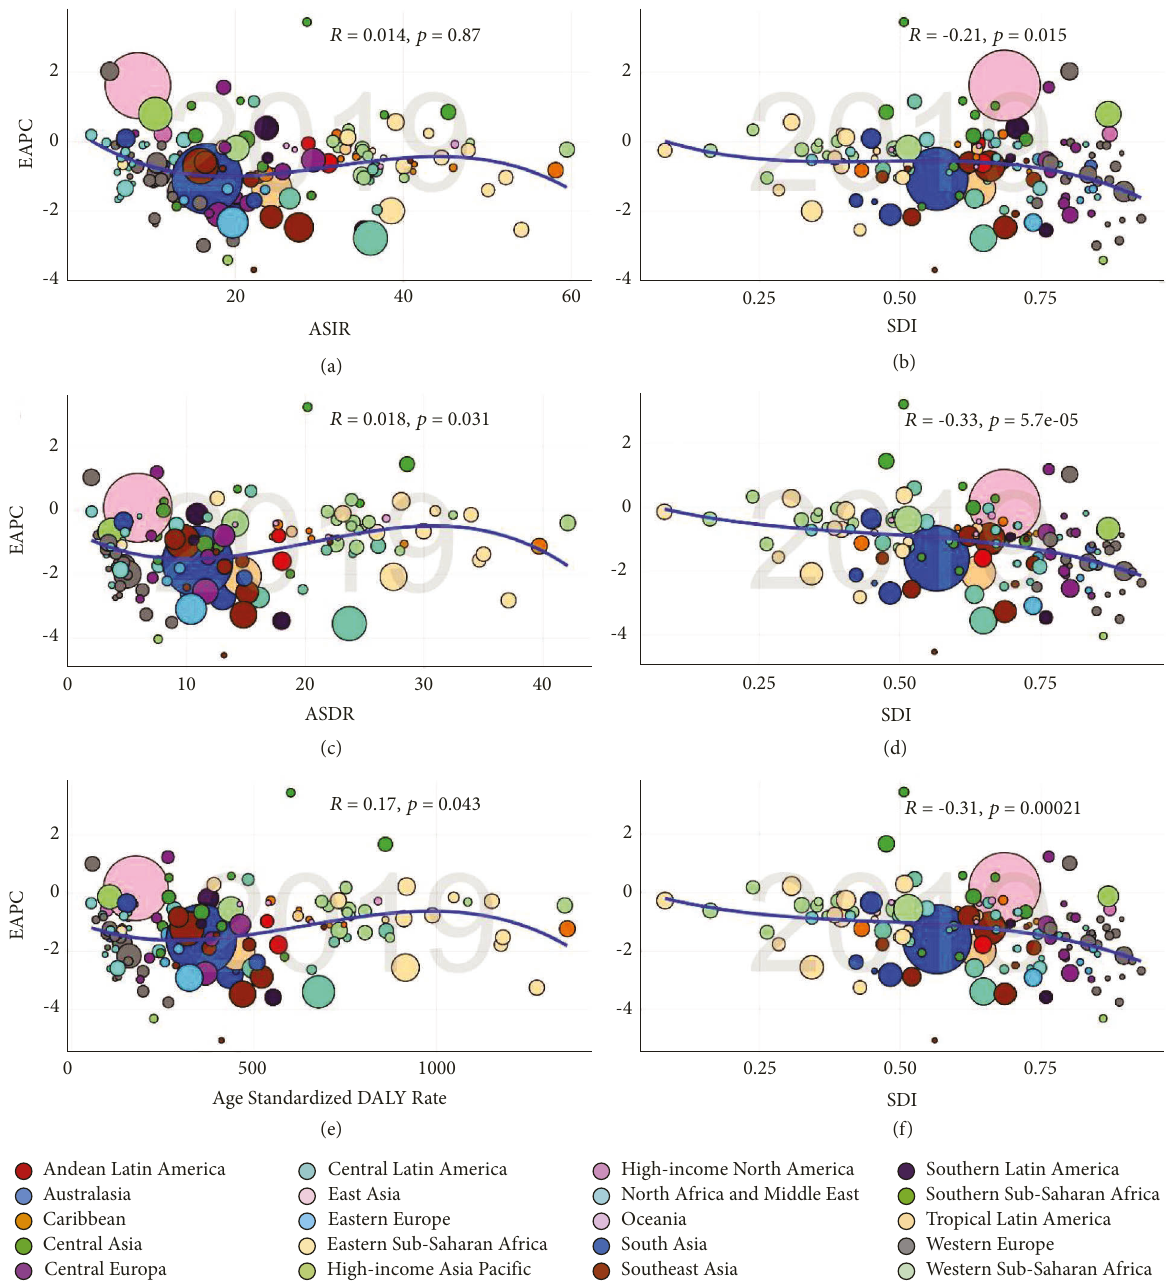
Figure 2: Correlation between EAPC and cervical cancer ASR (incidence (a), death (c), and DALY (e)) in 1990 and SDI (incidence (b), death (d), and DALY (f)) in 2019. The circle represents the country where the SDI data can be traced. The size of the circle represents the proportion of patients with cervical cancer. R index and P value were obtained by Pearson correlation analysis. ASR, age-standardized incidence/death/DALY rate; EAPC, estimated annual percentage change; SDI, social demographic